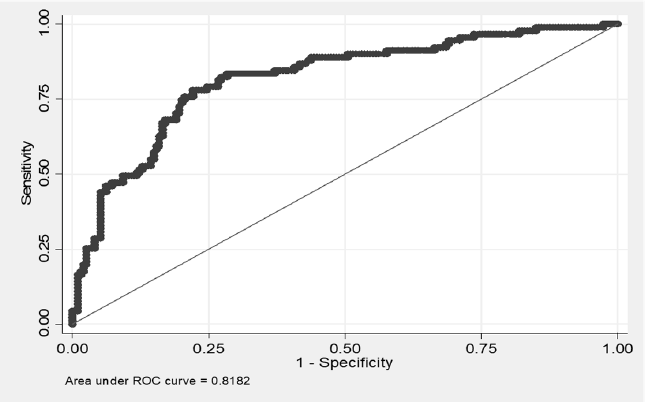
Figure 2. ROC curve of CX3CL1 predictive ability to discriminate fibrotic diffuse parenchymal lung disease (DPLD) from other (non-fibrotic) DPLDs. Youden’s index = 0.5586; the cut-off value of CX3CL1 associated with the highest value of Youden’s index is CX3CL1 = 868.62; sensitivity = 0.7802; specificity = 0.7784.